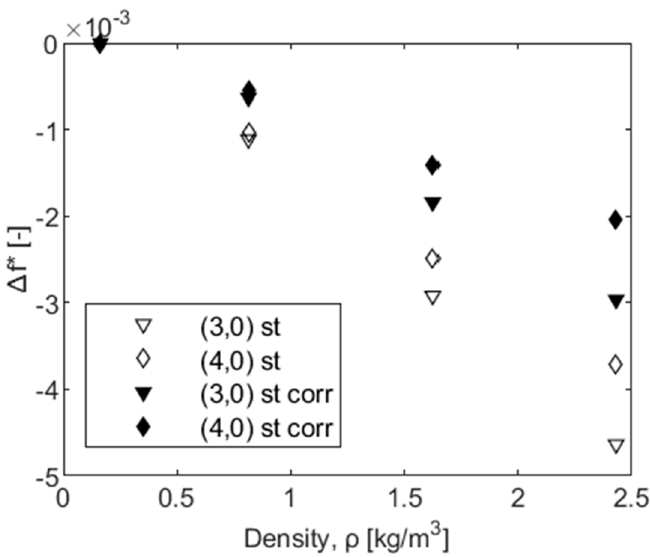
Figure 5. Corrected relative frequency changes of structure modes in helium for “wide cavity” over fluid density. Raw values and values corrected for added mass effect.